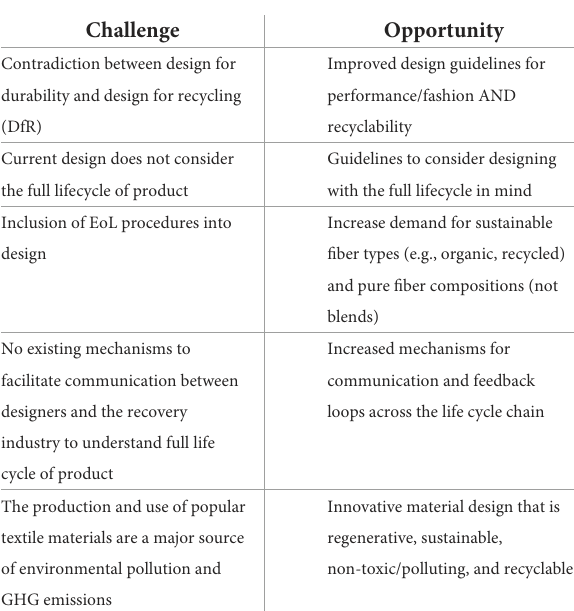
TABLE 6 Challenges and opportunities for circular